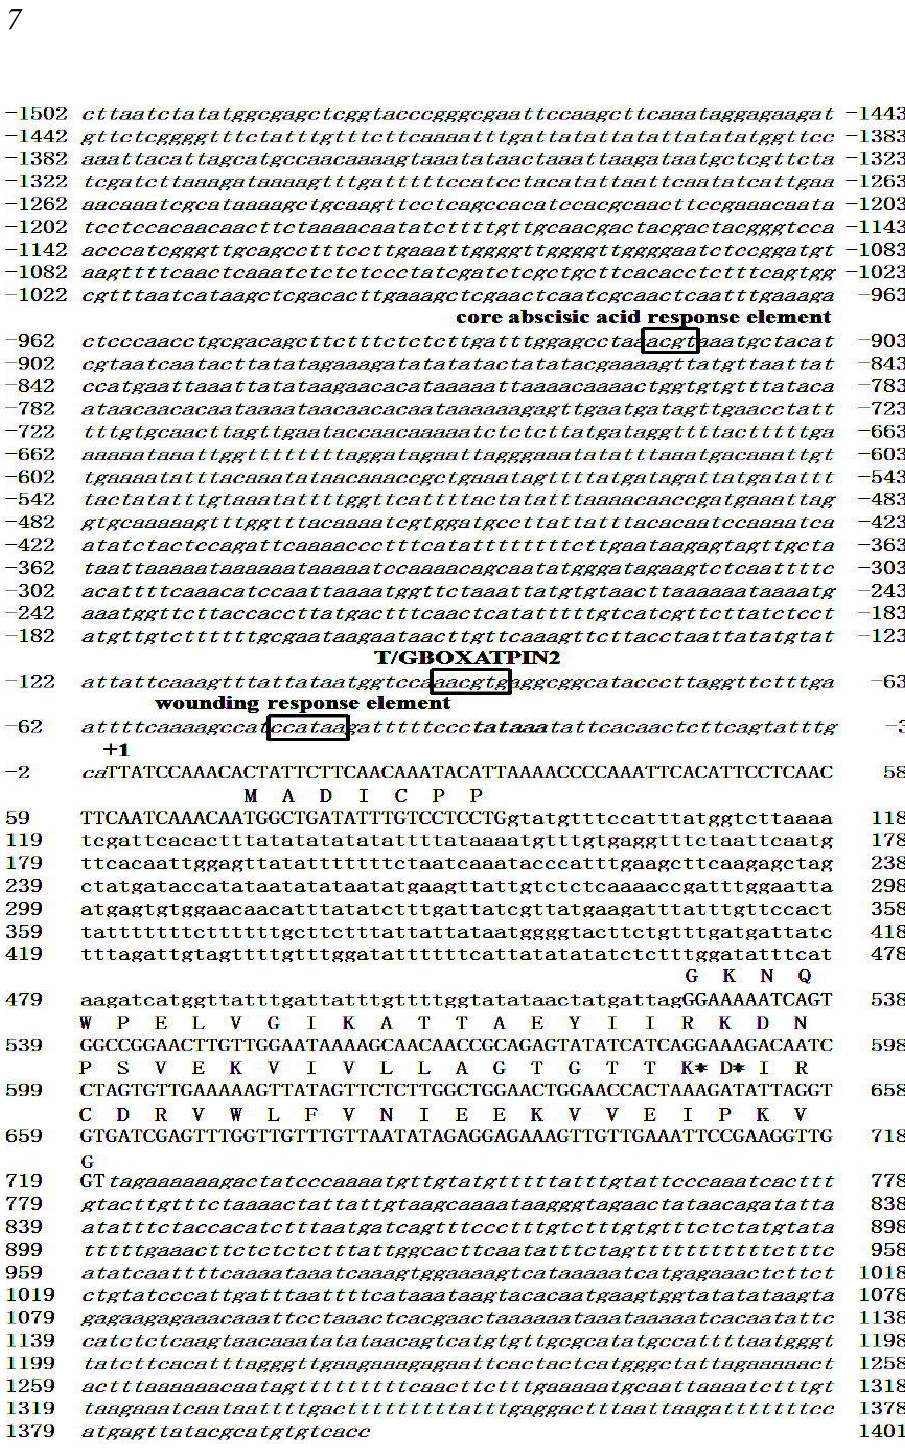
Figure 1. Nucleotide sequence of CmSPI . The nucleotide sequence of C. metuliferus CmSPI gene, including the 5′-flanking region and 3′-UTR, is shown. The transcription start site is labeled +1, and the TATA box is shown in boldface. The core abscisic acid response element, T/GBOXATPIN2 element, and wound response element are boxed. Asterisk marks indicate the predicted reactive sites, K48 and D49. Flanking region sequences are shown in italic letters. Exon and intron predicted sequences are shown in upper and lower case letters, respectively.